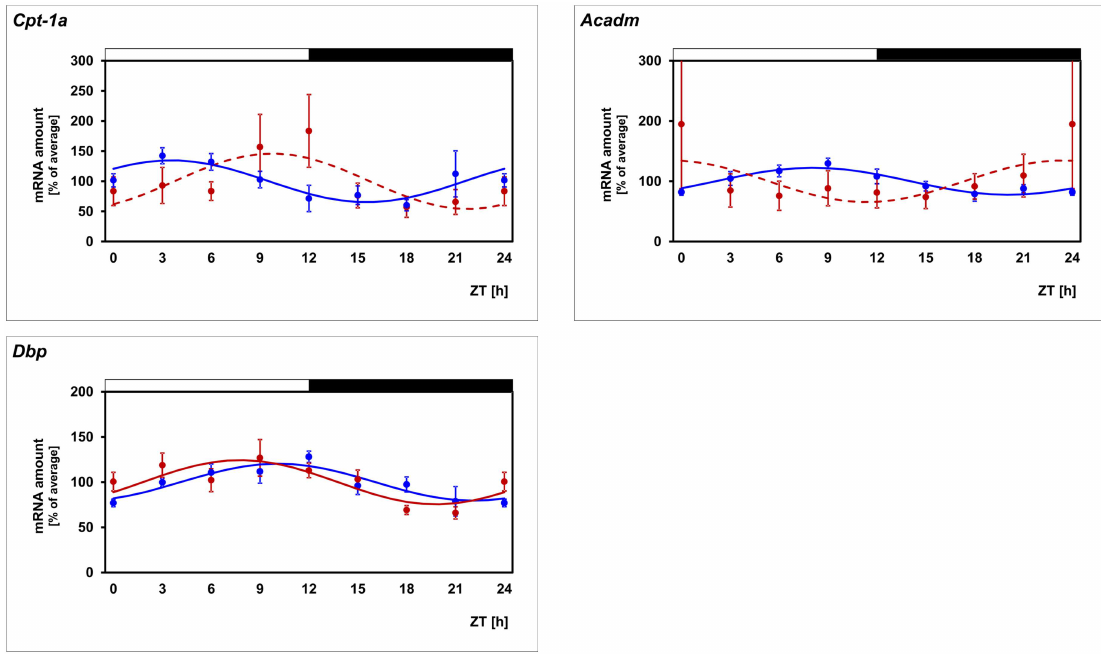
Fig 4. Daily profiling of enzymes of the FAO pathway in db/db mice. Transcript levels of Cpt-1 α and Acadm are recorded in non-diabetic db/+ mice (blue lines) and diabetic db/db mice (red lines) in preparations of the whole retina under light/dark (LD) 12:12 using qPCR. The mRNA levels are plotted as a function of Zeitgeber time (ZT) and the lines represent the periodic sinusoidalfunctions determined by cosinor analysis(solid and broken line for p < 0.05 and p > 0.05). Data represent a percentageof the averagevalue of the transcript amount during the 24-h period. Statistical analysis of transcriptional profiling is provided in Table 4. The value of ZT0 was plotted twice at both ZT0 and ZT24. The solid bars indicate the dark period. Each value represents mean ± SEM (n = 4; each n represents two animals / four retinae). Note that the daily profiles of Cpt-1 α and Acadm are modulatedin db/db mice whereas the reference gene Dbp is unaffected.